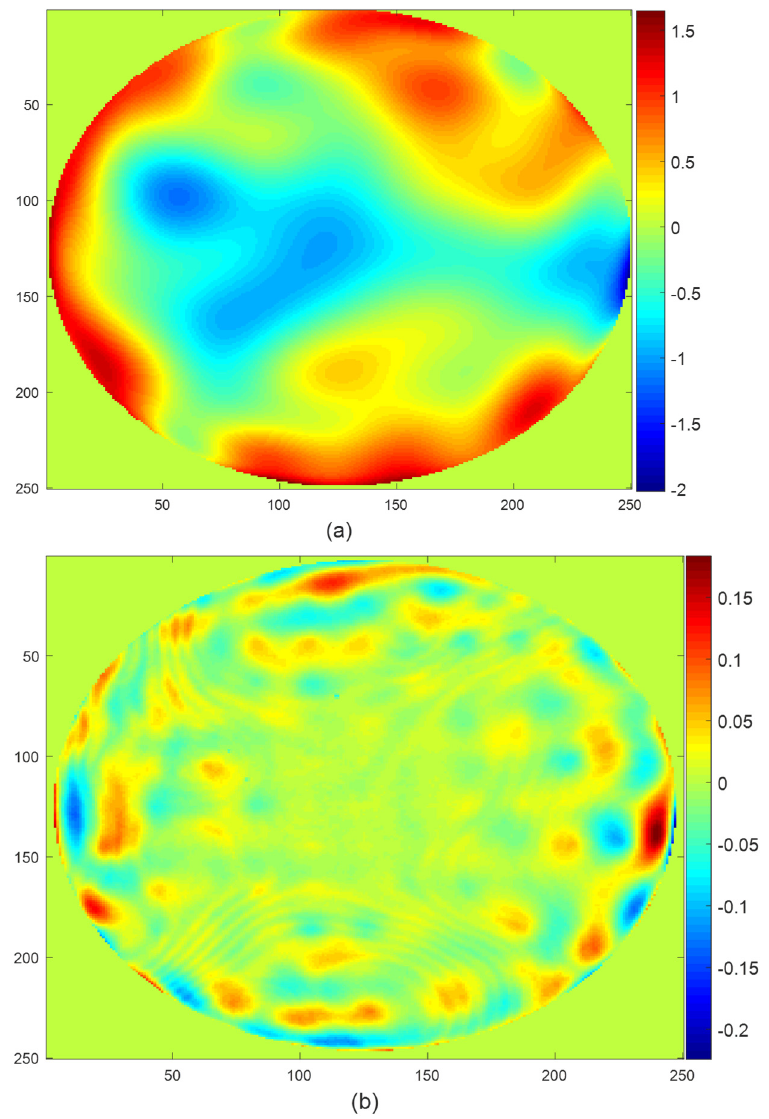
Figure 4. Simulation results of DM eigenmode correction ( a ) before and ( b ) after correction.